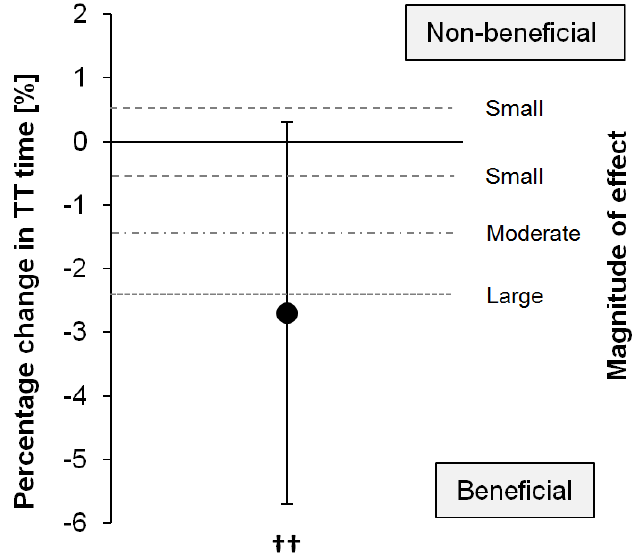
Figure 1. Percentage change and 90% confidence interval (CI) of cycling time trial finishing time between the Palatinose™ (PSE) and maltodextrin (MDX) trial ( N = 20). Thresholds for small, moderate, and large effects are indicated by dashed lines. †† denotes a likely small to moderate benefit, i.e., faster time trial performance with PSE compared with MDX.